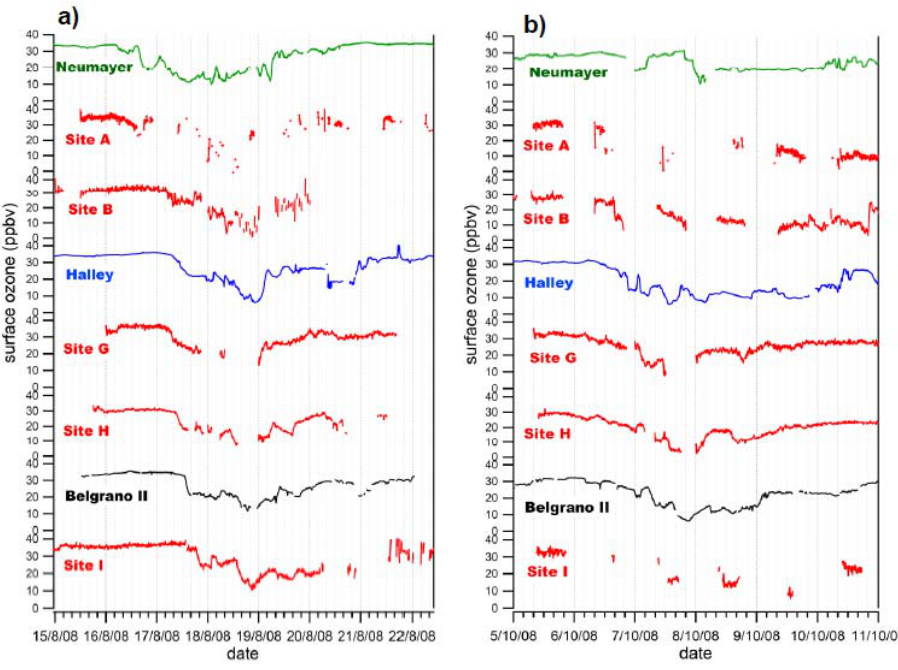
Figure 3. Major ozone depletion events that were evident at all coastal stations, a) from 16 th to 22 nd 579 Fig. 3. Major ozone depletion events that were evident at all coastal stations, (a) from 16 to 22 August, (b) from 6 to 11 October. Tick marks August, b) from 6 th to 11 th October. Tick marks denote midnight at the start of the day. 580 denote midnight at the start of the day. 581